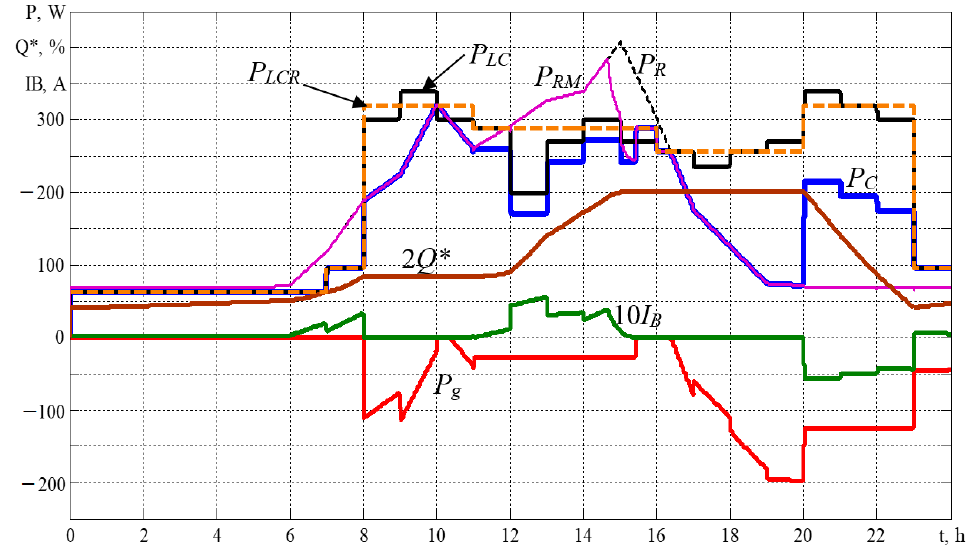
Figure 6. Oscillograms for May Day at P LC ≠ P LCR ( P LC , load power; P LCR , a specified value of the load power; P C , load added power; P R , the actual power of RES; P RM , maximum power of RES; P g , power consumed from the grid; P W , WG power; I B , battery current; Q* , battery state of charge).